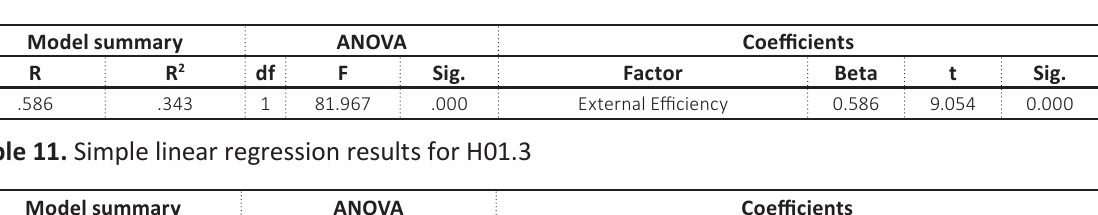
Table 10. Simple linear regression results for H01.2